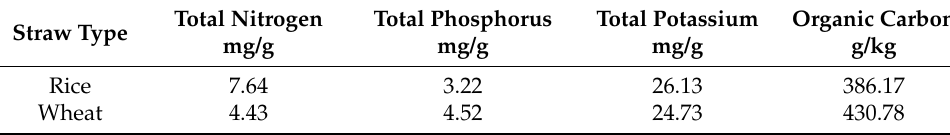
Table 1. Nutrient content of dry wheat and rice straw. Straw